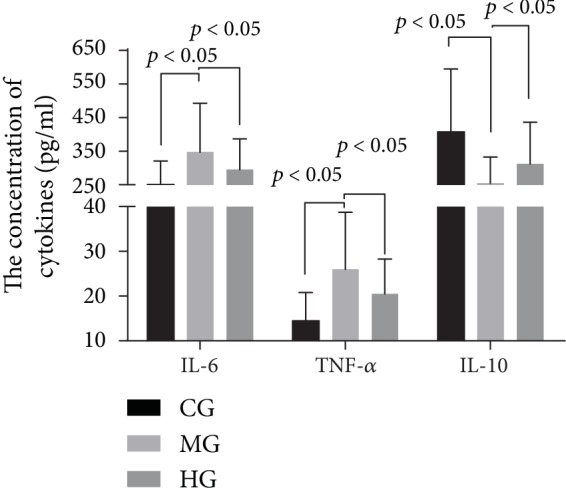
ELISA analysis of the effects of hydrostatin-SN10 on the secretory activity of cytokines (IL-6, TNF-α, and IL-10). All mice were allocated into three groups: CG (wild group), MG (pancreatitis-induced lung injury model group), and HG (hydrostatin-SN10-treated model group). n = 12 for each group, and statistical difference was significant if p < 0.05.